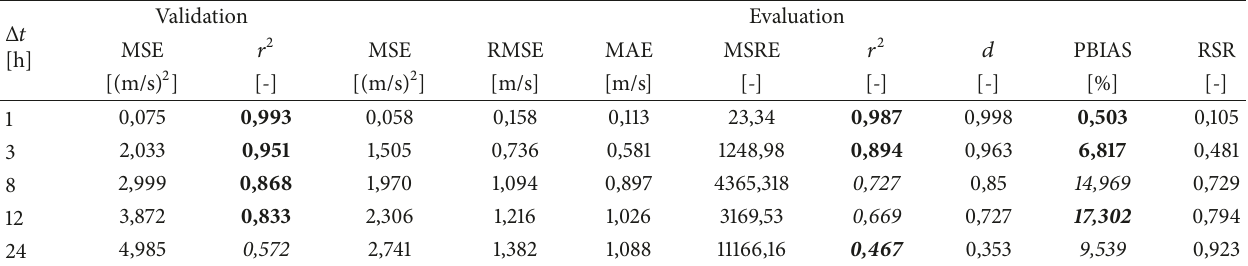
Table 2: Performance statistics of the ANN model during validation and evaluation